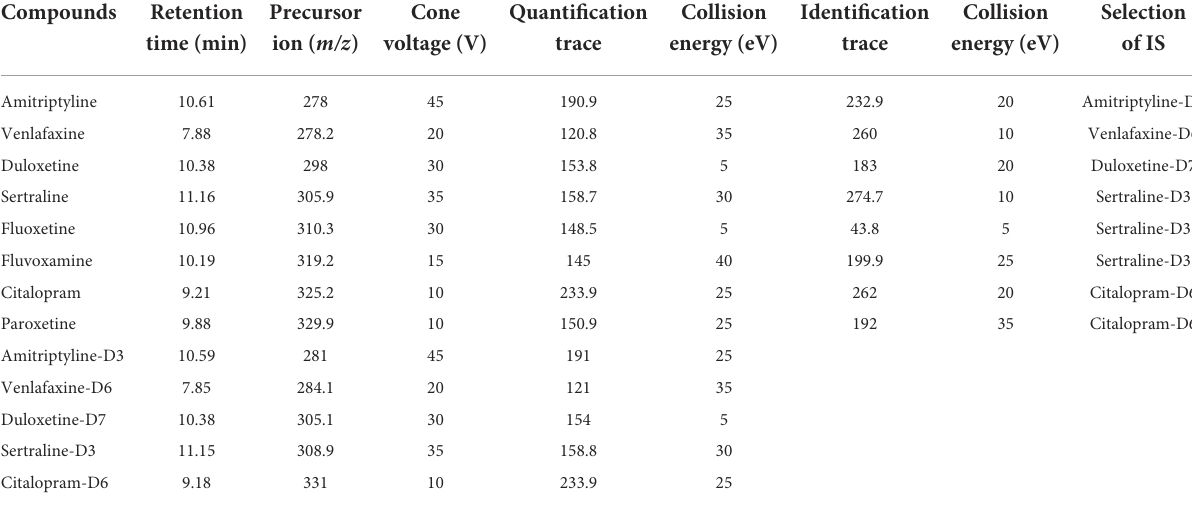
TABLE 1 List of the optimized MRM parameters and the selection of IS. Compounds